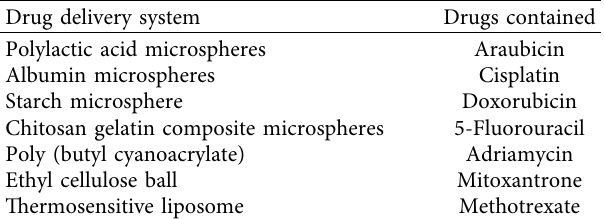
Table 1: Targeted delivery system of chemotherapy drugs. Drug delivery